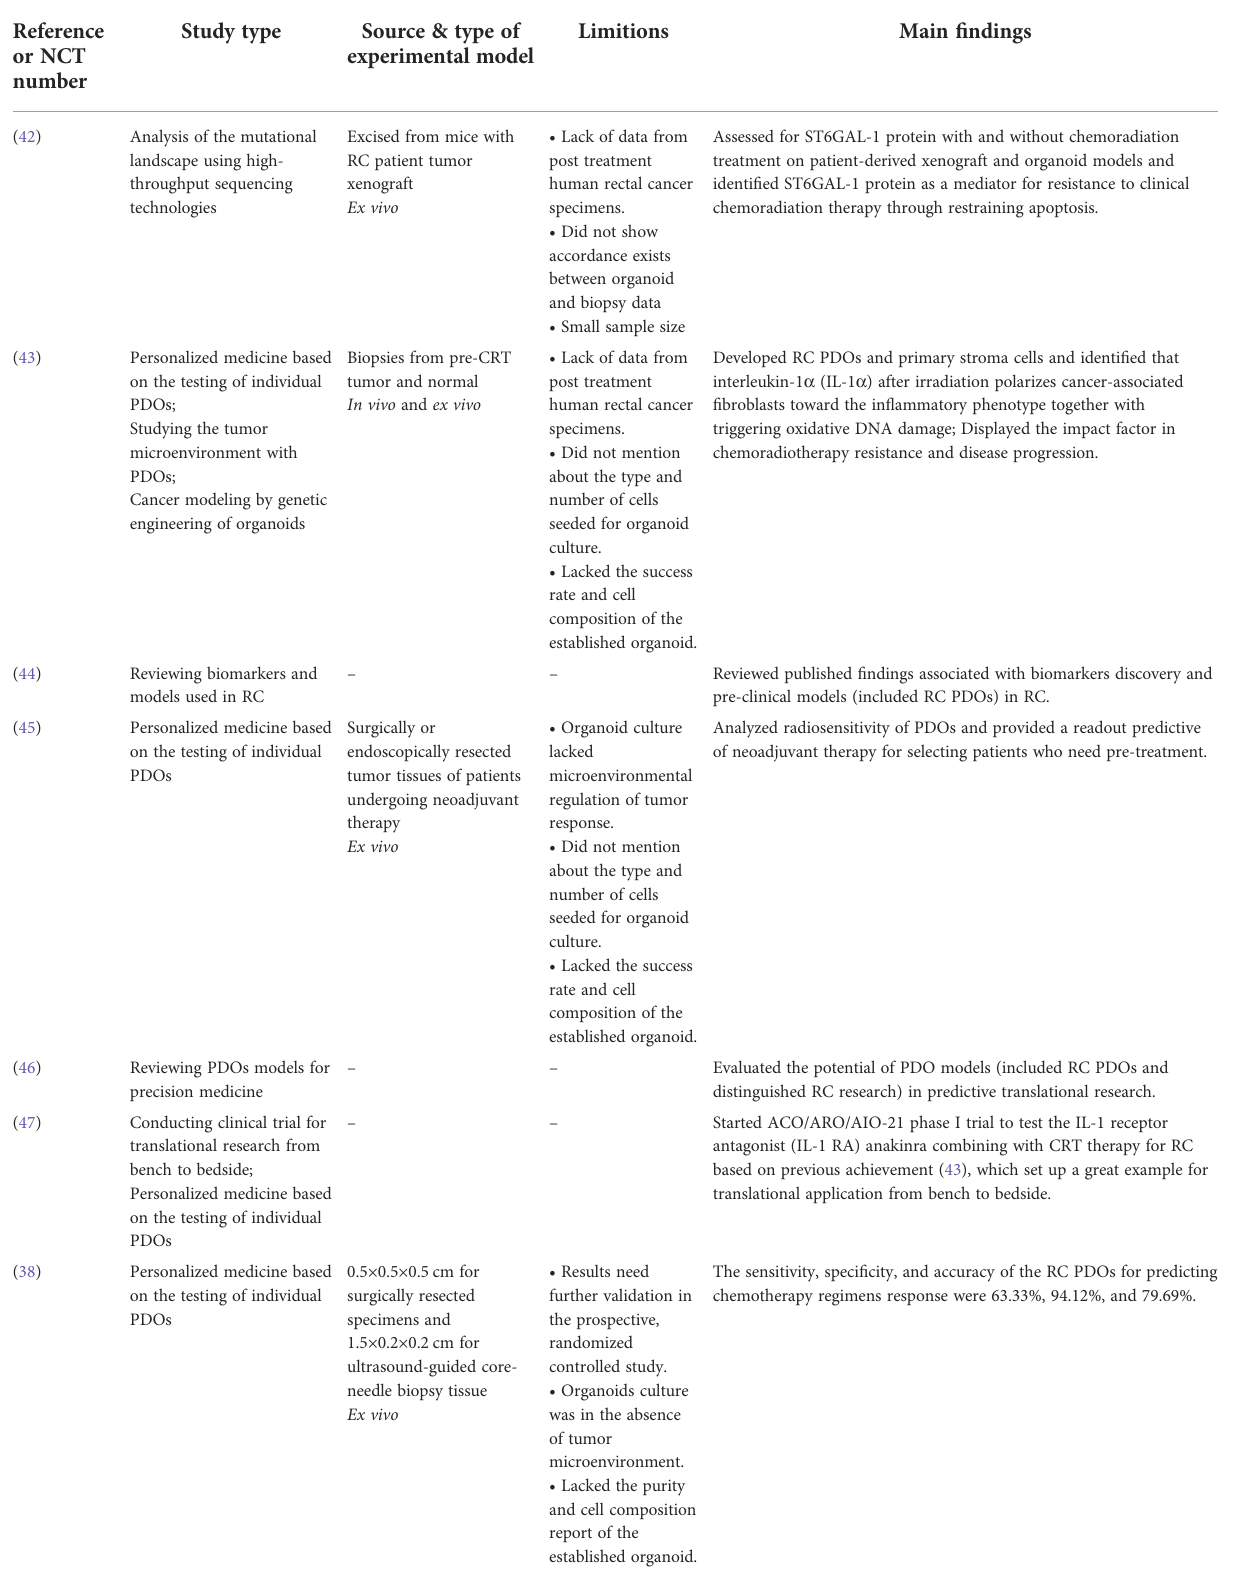
TABLE 2 Summary characteristics of included publications (n = 21) and clinical studies (n =